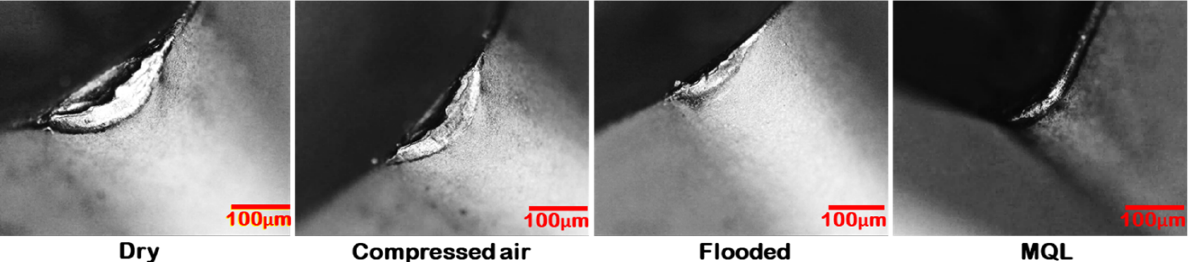
Figure 6. Images of flank wear under various turning environments at v = 67 m/min, and f = 0.24